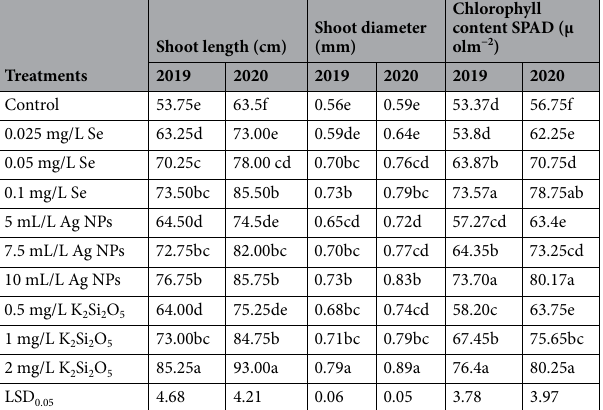
Table 2. Influence of the foliar spraying of Se, Ag NP S and K 2 Si 2 O 5 on shoot length, shoot diameter, and leaf total chlorophyll in “Succary” pomegranate cultivar 2019 and 2020 seasons. Means not sharing the same letter(s) within each column are significantly different according to LSD at 0.05 level of significance.